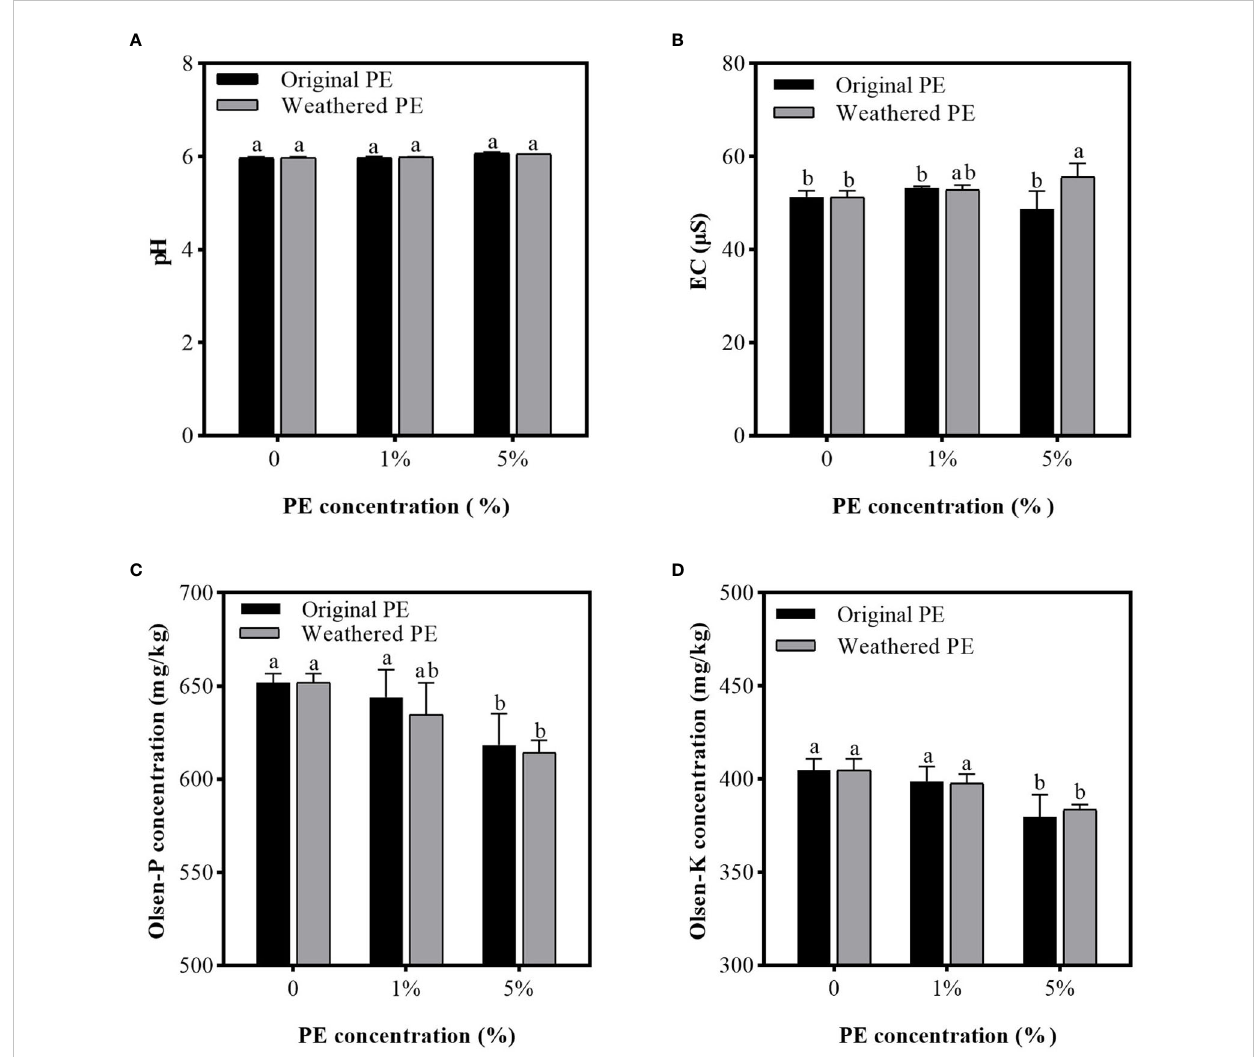
FIGURE 1 pH (A) , EC (B) , Olsen-P (C) , and olsen-K concentration (D) in PE MPs and Cd compound-contaminated soil. Soil samples are collected after sweet potatoes are treated by original or weathered PE MPs (0, 1% and 5%) for 15 days. Different letters in each fi gure indicate signi fi cant (p < 0.05) differences according to Tukey ’ s